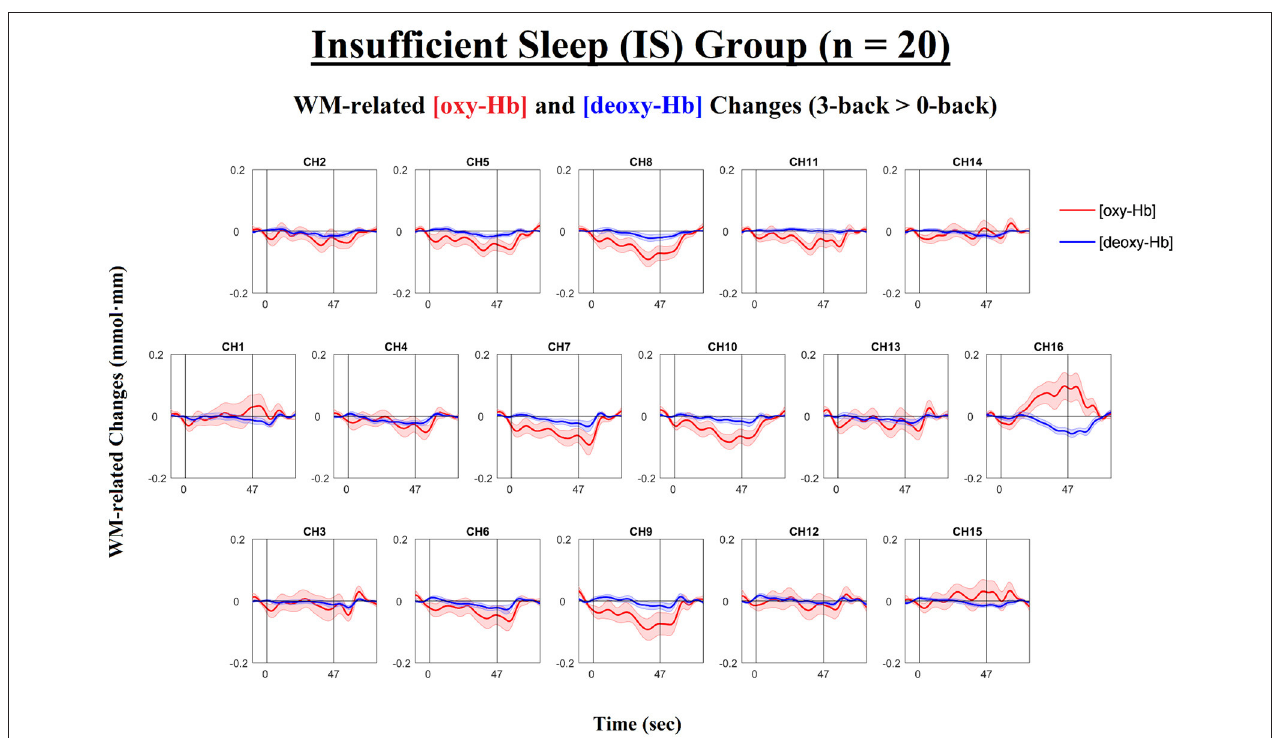
FIGURE 4 | Time courses of the working-memory-related (WM-related, i.e., 3-back minus 0-back) [oxy-Hb] and [deoxy-Hb] changes in the Insufficient Sleep group (IS; n = 20). Each n -back block started at 0s, began with an instruction cue that lasted for 5s, and ended at 47s. None of the channels exhibited significant WM-related [oxy-Hb] increases (i.e., mean [oxy-Hb] values over the 42-s active task period, excluding the cue period) or significant WM-related [deoxy-Hb] decreases (i.e., mean [deoxy-Hb] values over the 42-s active task period, excluding the cue period) ( p s < 0.05; FDR-corrected). Lines and shading indicate the mean ± 1 standard error.